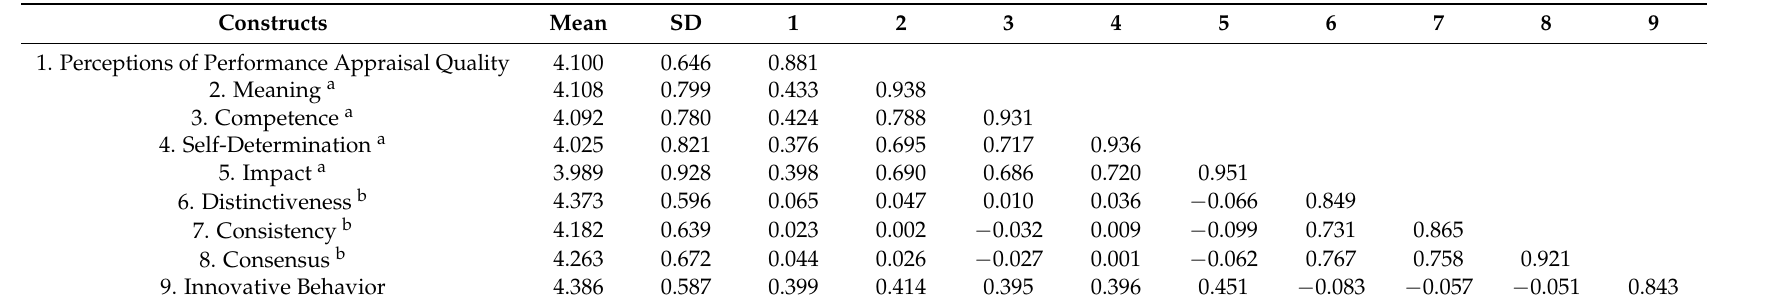
Table 2. Means, Standard Deviations, and Correlations among